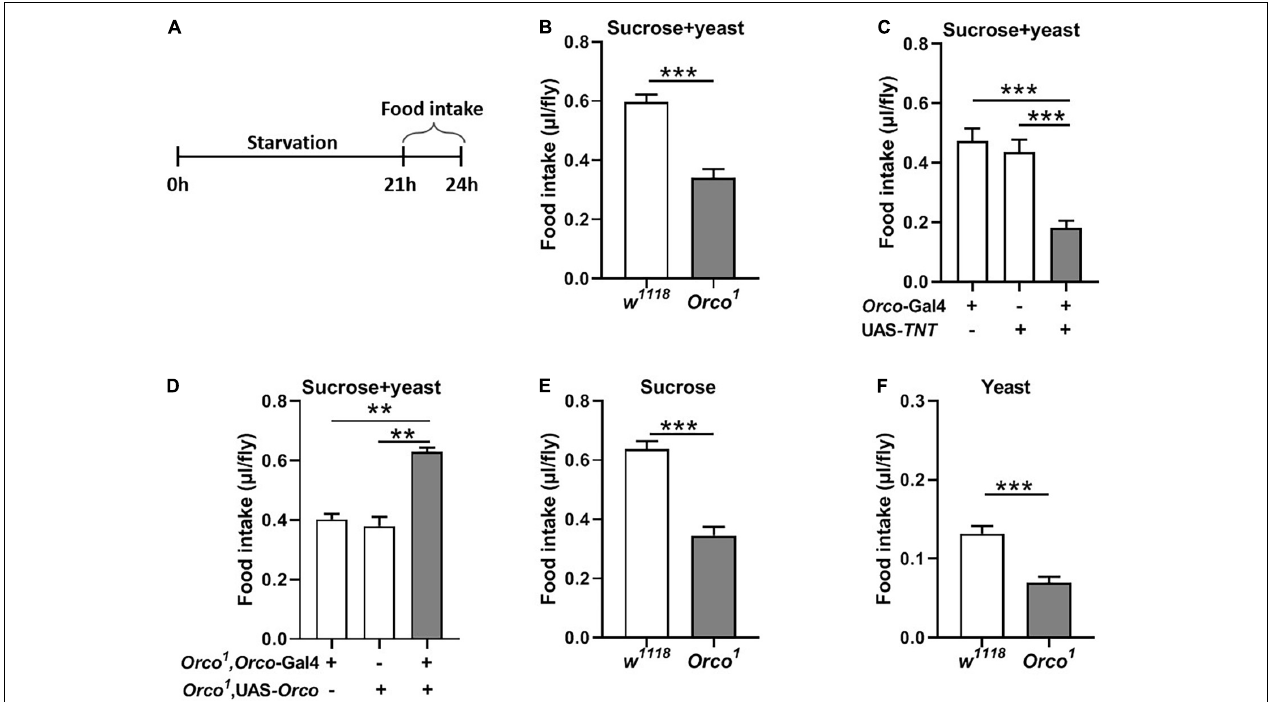
FIGURE 2 | Blocking OSNs decreases the food consumption in starved flies. (A) Schematic for food intake of starved flies. (B) After 21 h starvation, Orco 1 mutant flies consumed less liquid food containing 5% sucrose and 5% yeast extract than control w 1118 flies ( n = 12). (C) Expression TNT in OSNs decreased food consumption ( n = 12). (D) Expression of Orco in OSNs of Orco 1 mutants flies rescued food intake ( n = 15). Starved Orco 1 mutant flies consumed less single sucrose food ( n = 19–20) (E) or yeast extract food ( n = 12) (F) . ** p < 0.01 and *** p <